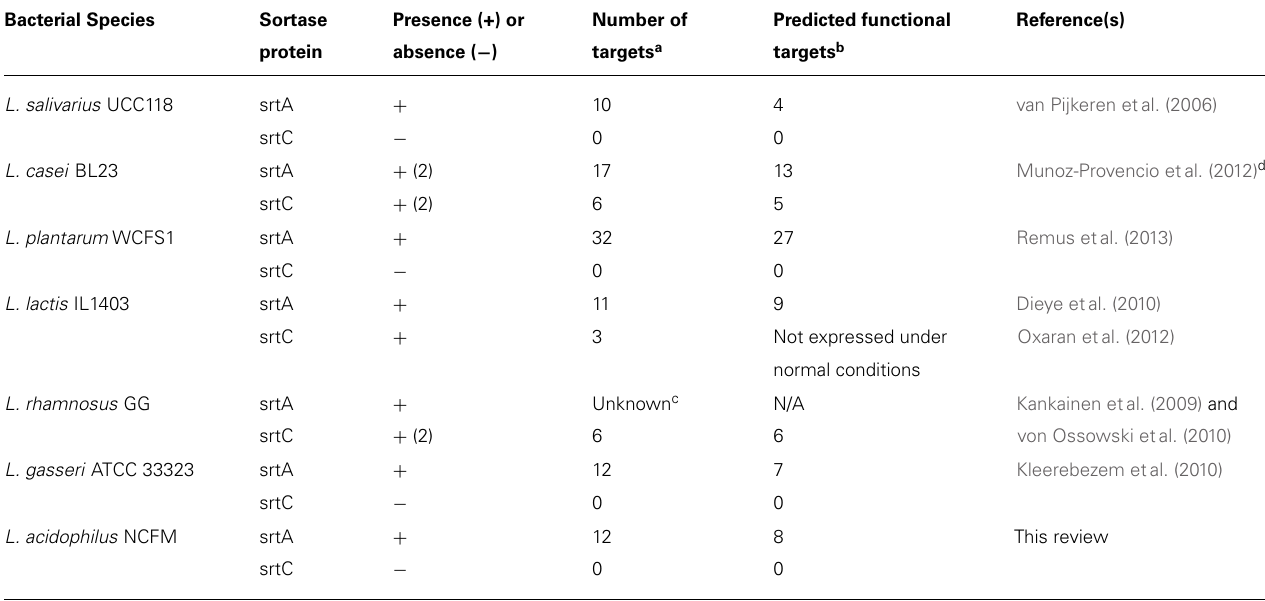
Table 1 | Comparative genomic analysis of sortase-dependent proteins in select species of LAB. Bacterial Species Sortase Presence (+) or Number protein absence ( − )